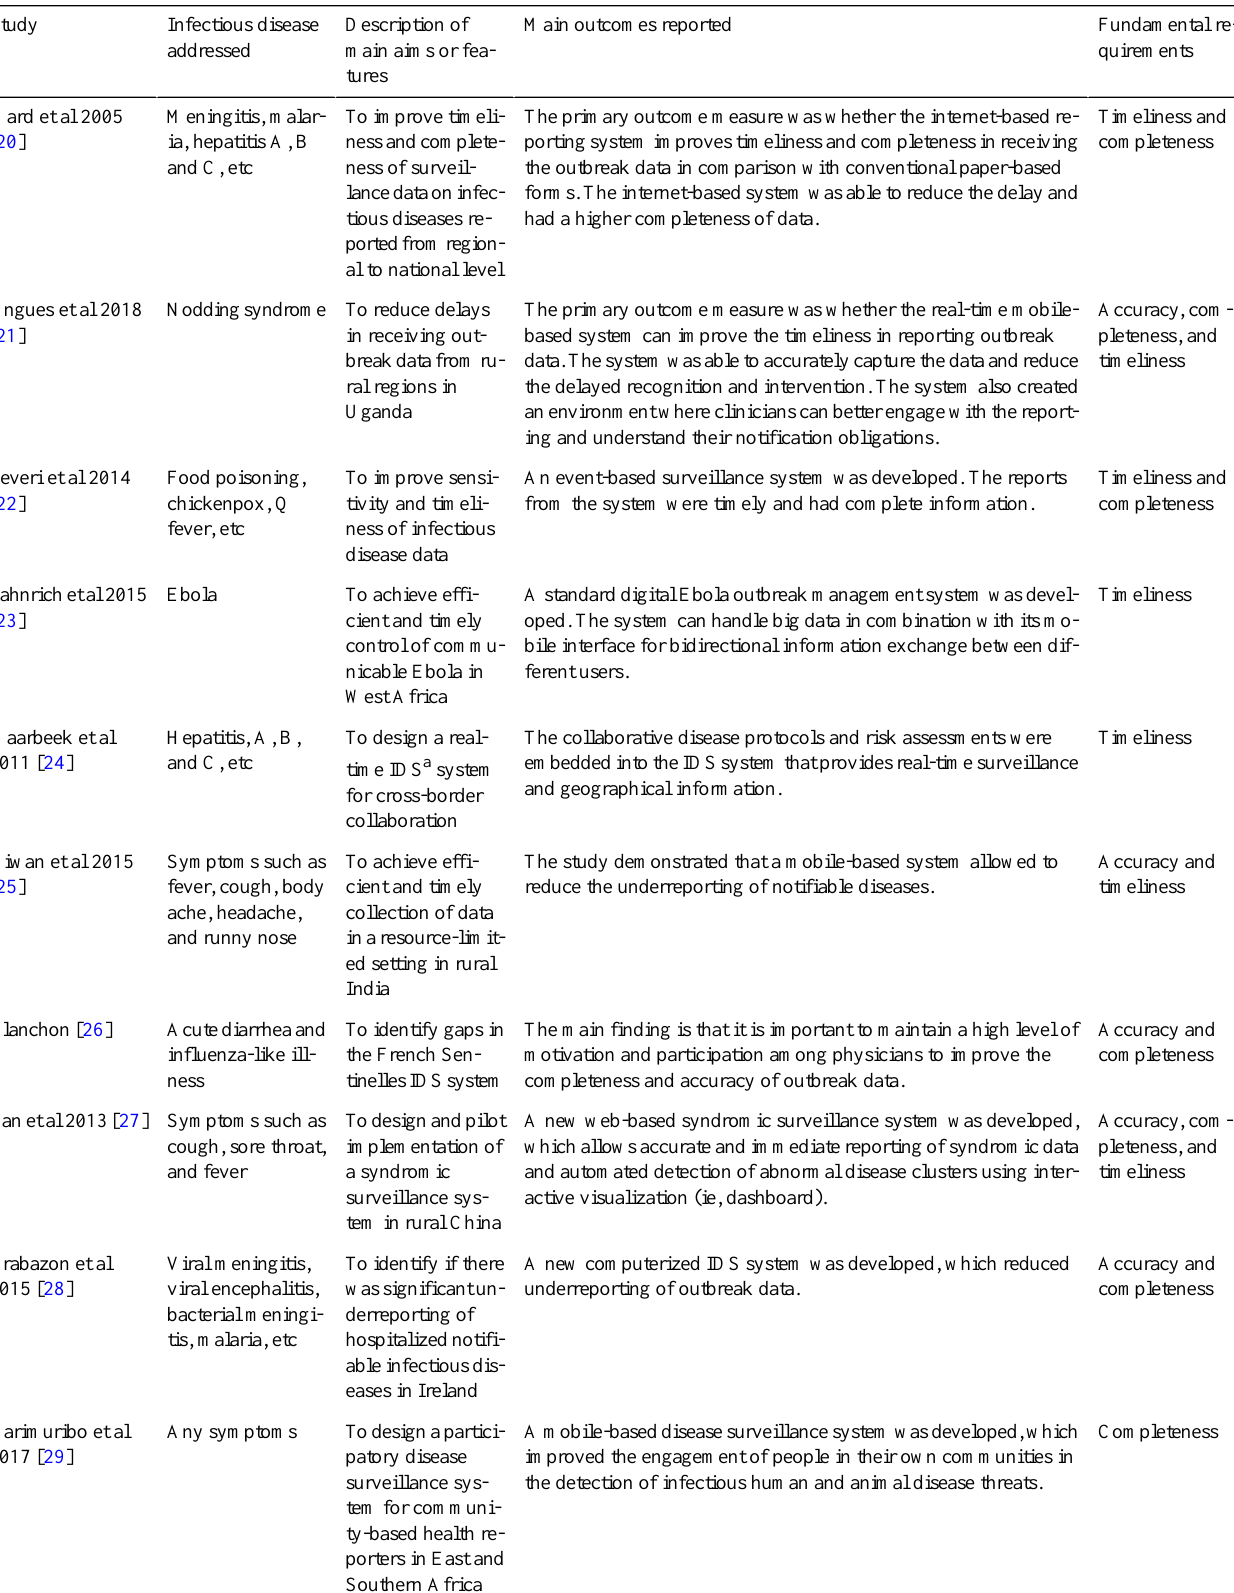
Table 1. The descriptions of existing infectious disease surveillance systems found from our literature